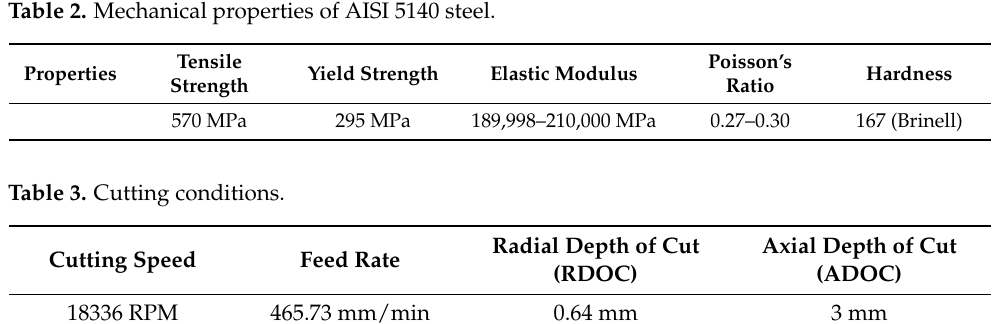
Table 3. Cutting conditions.